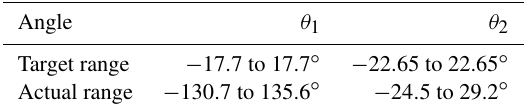
Table 3. Joint angle